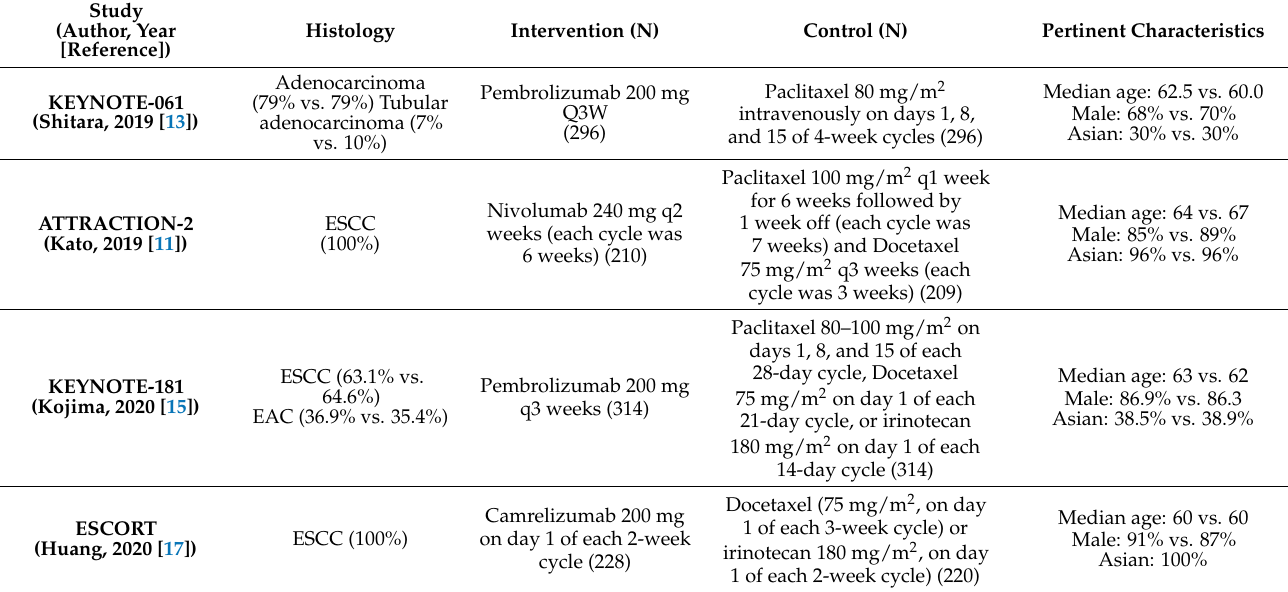
Table 3. Characteristics of Trials Included in the Network Meta-Analysis of second-line